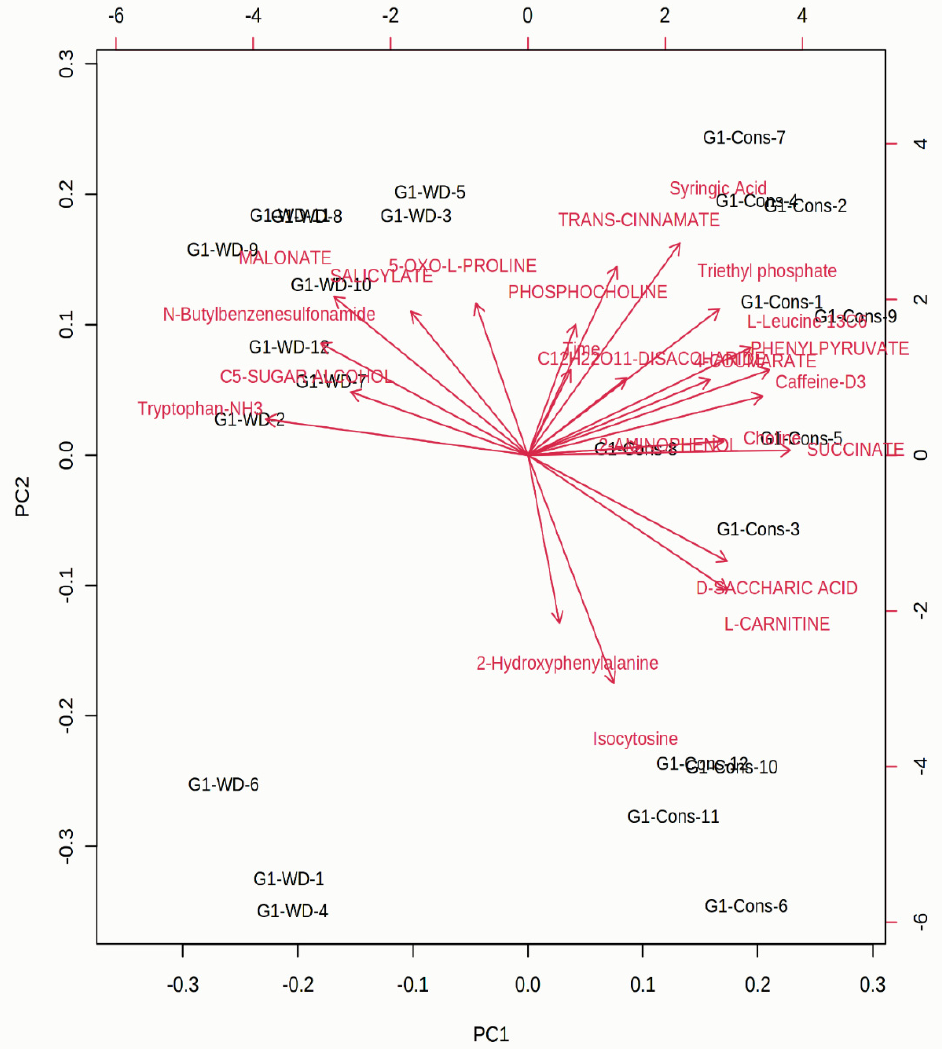
Figure 4. A PCA-based biplot showing the associations among different metabolites induced by plant growth-promoting rhizobacteria (PGPR) in chickpea leaves grown under stress conditions. The figure was generated by uploading data files to the MetaboAnalyst 3.0 server (http://www.metaboanalyst.ca accessed on 10 February 2021). We selected normalization by sum, log transformation, and auto-scaling for the analysis.